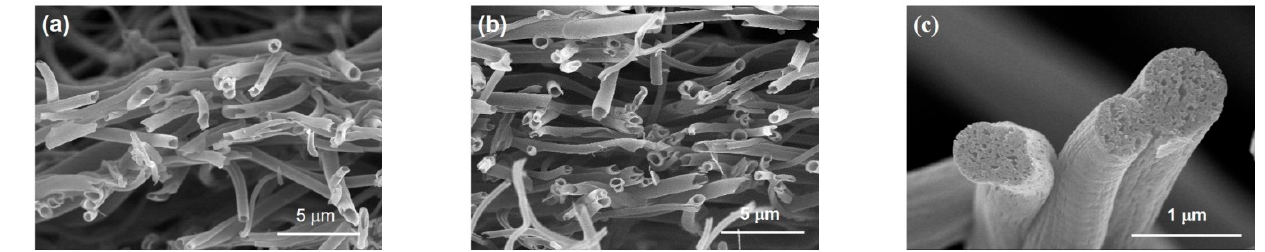
Figure 1. FESEM images of the carbonized samples of: ( a ) PANh15; ( b ) PANh12; ( c ) PANp.